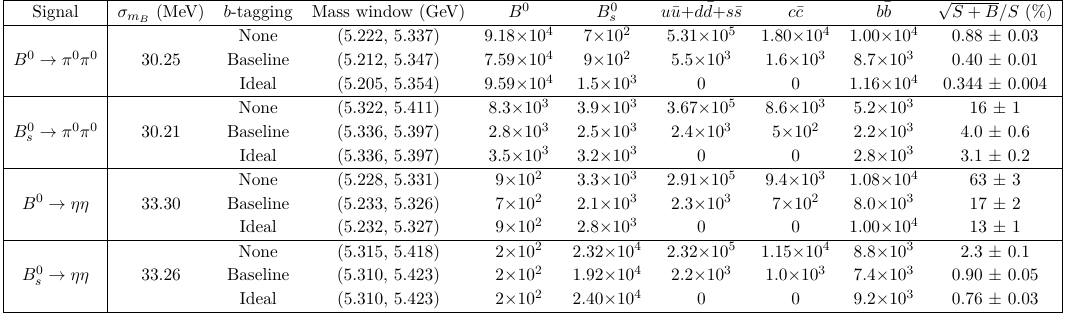
Table 10 . Measurement precisions of B 0 → π 0 π 0 , B 0 b -tagging conditions when ECAL energy resolution is 3% √